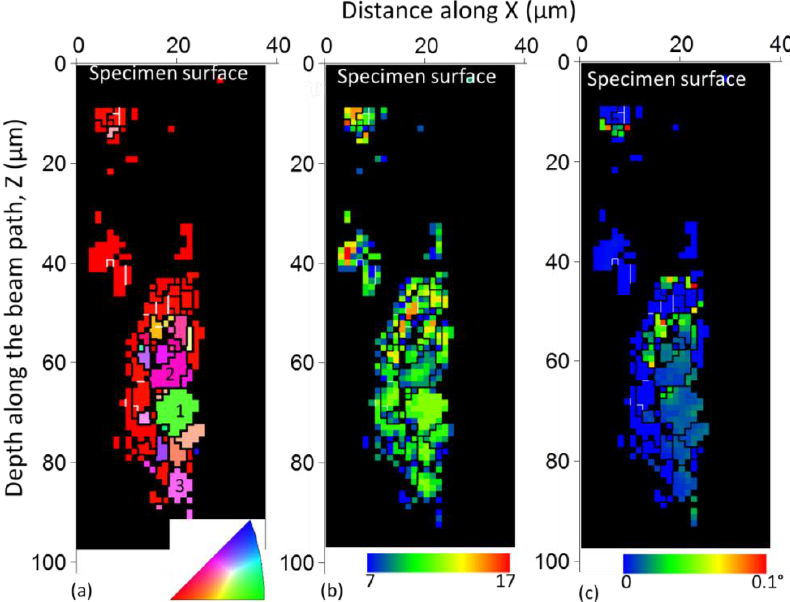
Figure 7. Microstructure of partially recrystallized Ni processed by accumulative roll bonding (ARB) characterized by DAXM: ( a ) Orientation map; ( b ) map of the number of indexed spots and ( c ) KAM map. The colors in ( a ) represent the crystallographic orientation along specimen normal direction (see the inset in ( a )). In the maps, boundaries with misorientation angles in the range of 0.1 – 1°, 1 – 3°, and >3° are shown in thin white, thin black, and thick black lines, respectively. The black individual pixels/regions are non-indexed. For KAM calculation, a cut-off angle of 0.1° is used. Numbers 1 – 3 are used to mark grains for monochromatic energy scans.